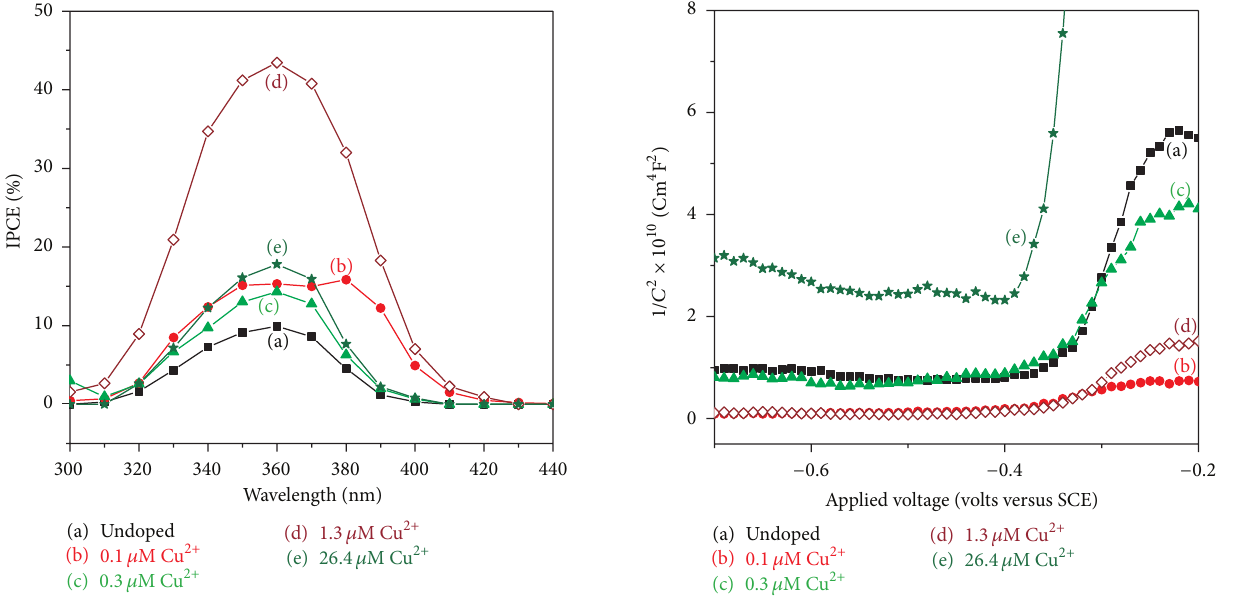
Figure 7: IPCE conversion efficiency for the ZnO films of different doping concentrations.